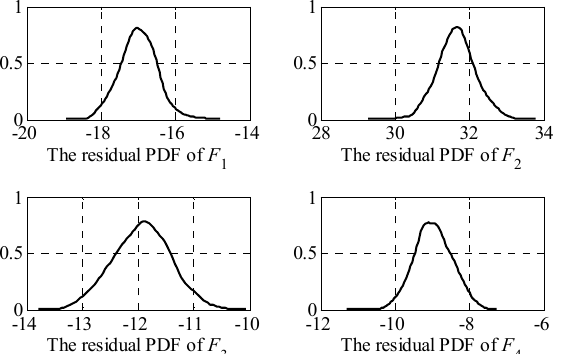
Figure 5. Estimation of residual probability density function (PDF).